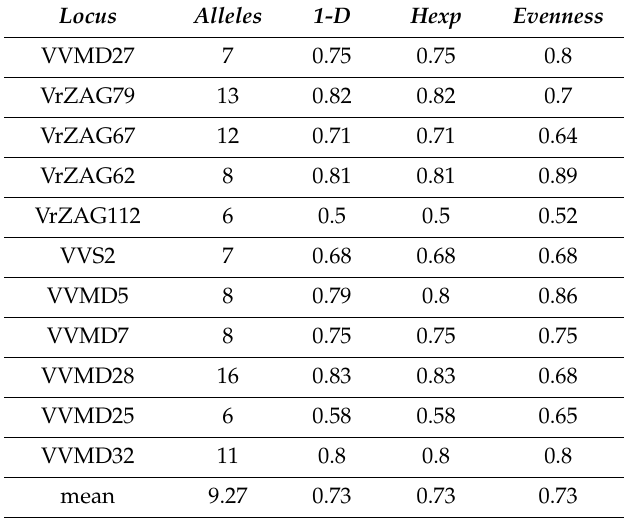
Table 2. Allele summary statistics for the 11 analyzed loci of Cypriot grapevine populations. Locus Alleles 1-D Hexp